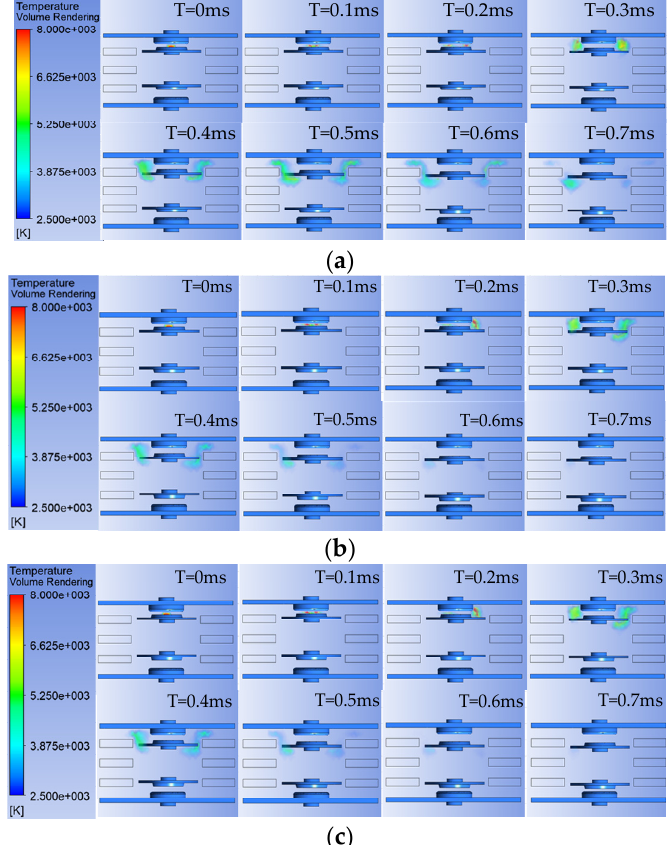
Figure 10. Simulation diagram of arc temperature. ( a ) Temperature diagram at different moments under 410 V/13 A, ( b ) Temperature diagram at different moments under 240 V/21 A, ( c ) Temperature diagram at different moments under 188 V/28 A.